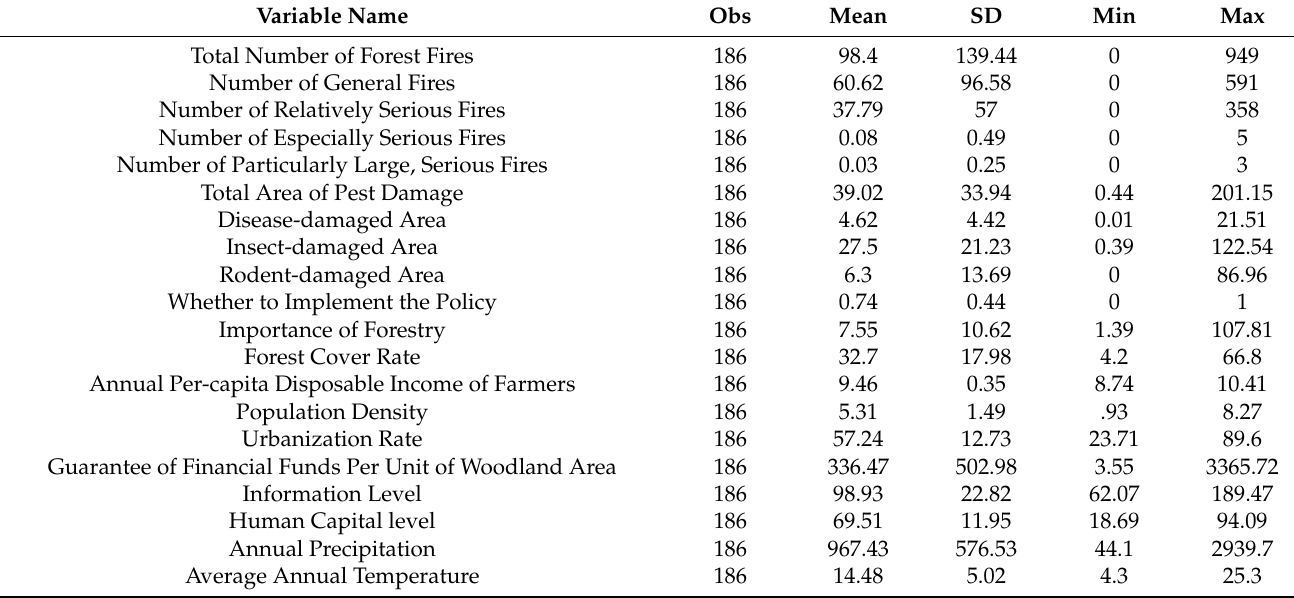
Table 2. Summary